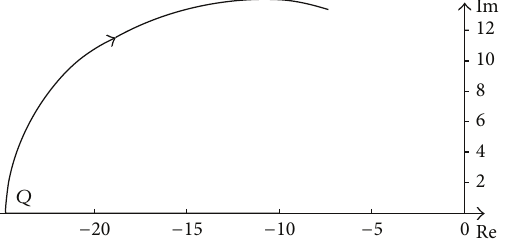
Figure 9: Locus of the second eigenvalue with 𝜏 increasing. (𝜏, 𝑧 ) = (0.0476𝑠, −1/𝑒) and it indicates the occurrence of 1 𝑅